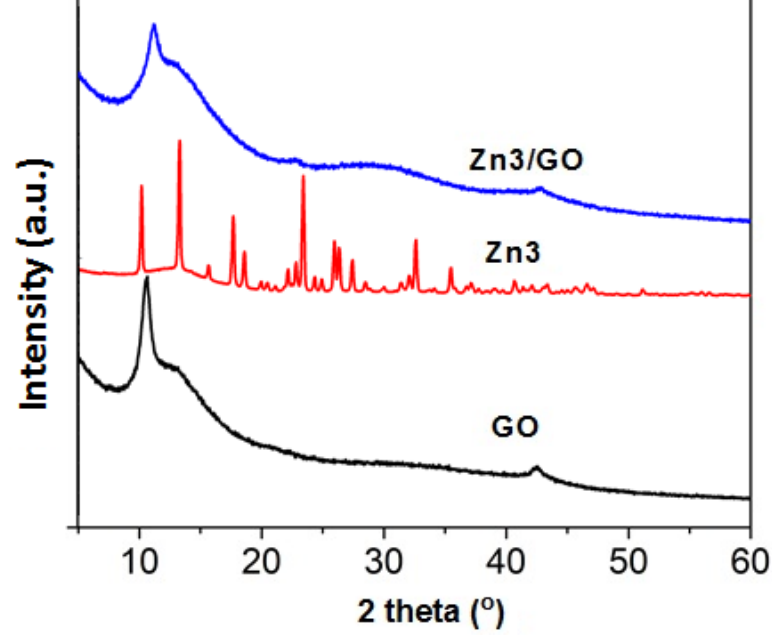
Figure 7. XRD patterns of GO, Zn3 and Zn3 /GO.